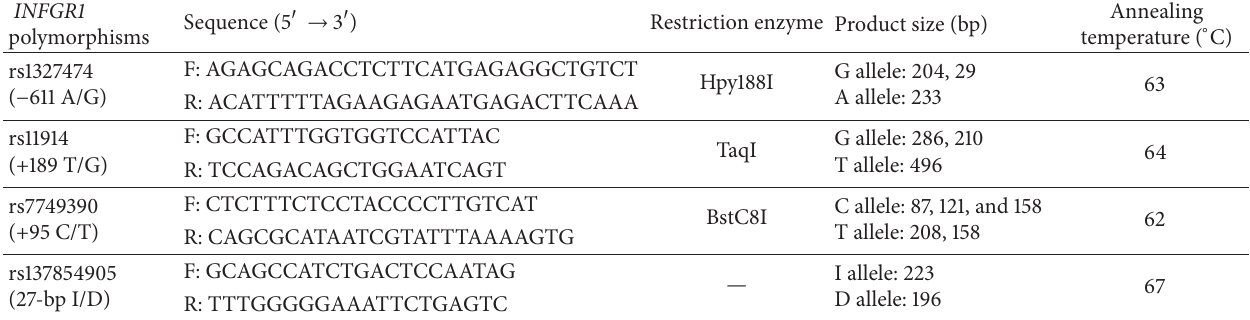
Table 1: Primers sequences used for detection of INFGR1 gene polymorphisms.